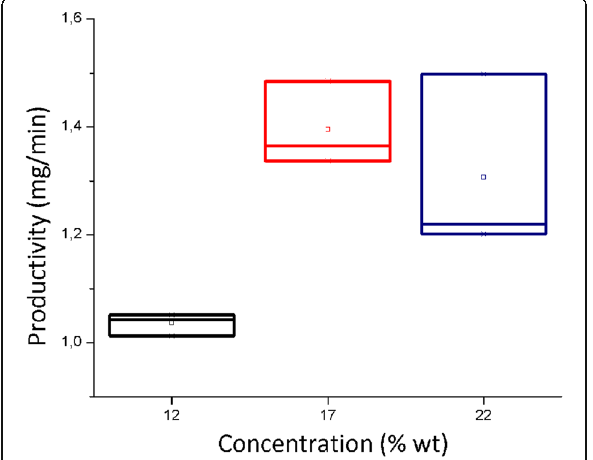
Fig. 2 Productivity of the basic electrospinning